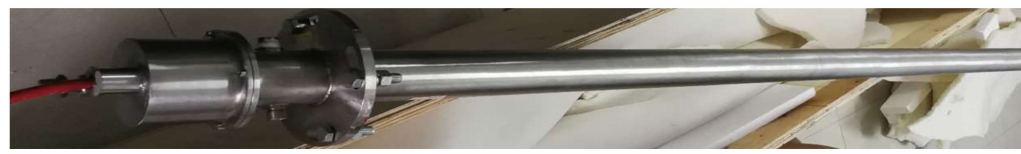
Figure 4. Photograph of the imaging component.